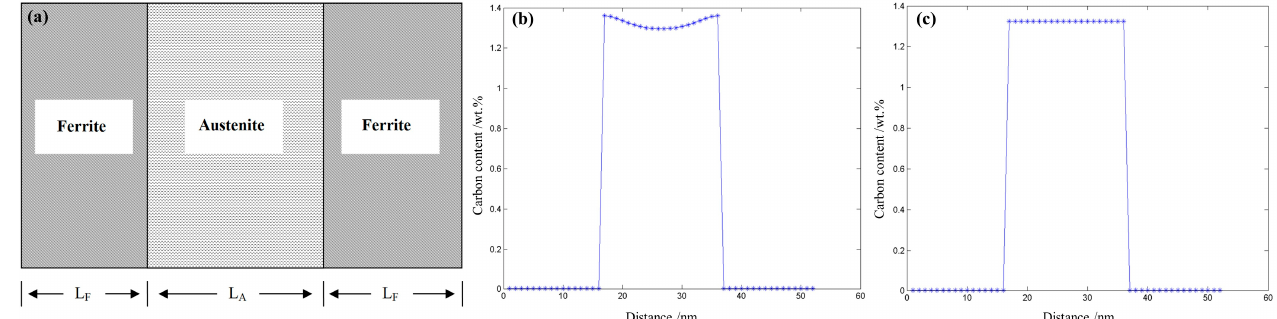
Figure 8. ( a ) the relative position in calculation system (L A = 20 nm, L F = 15 nm), ( b ) the carbon distribution at t = 0.0001 s,